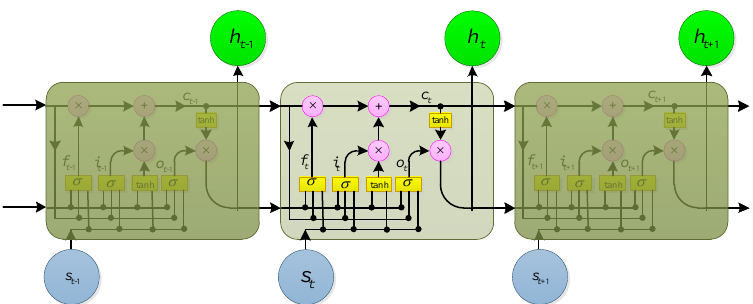
Figure 5. An illustration of a long short-term memory (LSTM) cell.